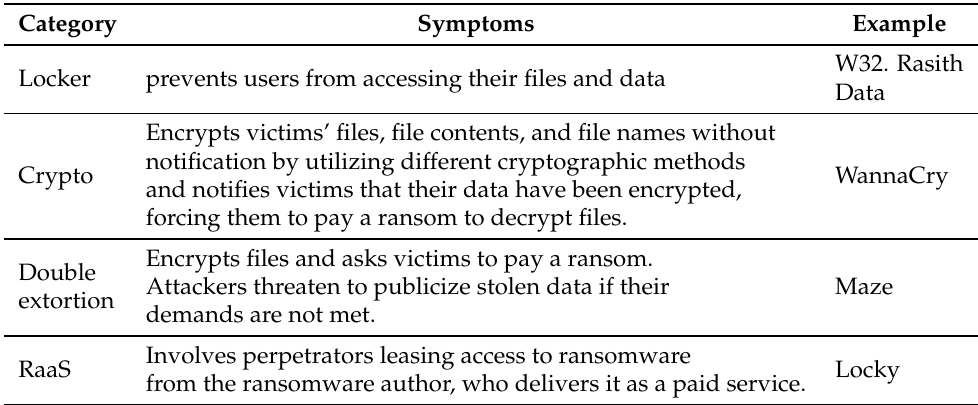
Table 1. Ransomware